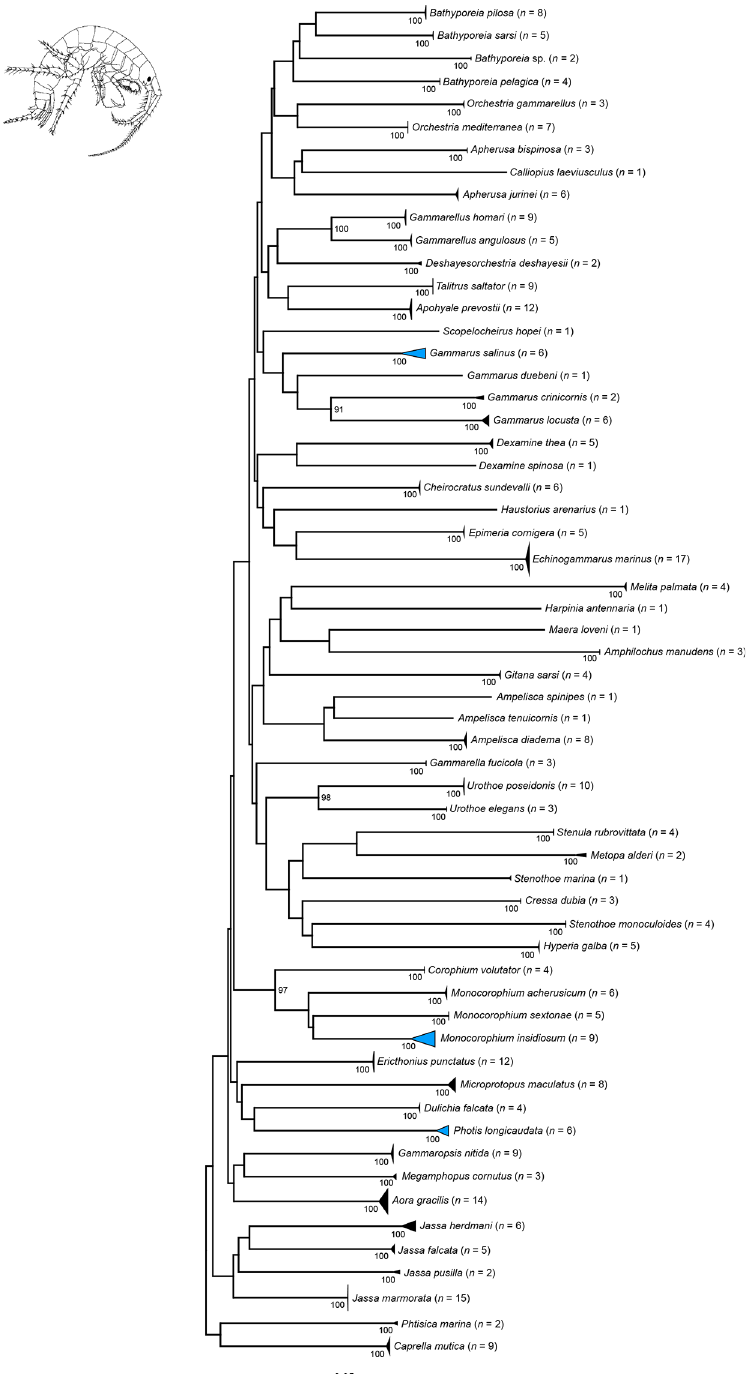
Fig 2. Neighbor joining topology of the analyzed Amphipoda based on Kimura 2-parameter distances. The number of analyzed specimens collapsed into a single node is provided following the species name. Triangles indicate the relative number of individual ’ s sampled (height) and sequence divergence (width). Blue triangles indicate species with intraspecific maximum pairwise distances > 2.2%. Numbers next to nodes represent non-parametric bootstrap values > 90% (1,000 replicates). Drawing of Melita palmata Montagu, 1804 is taken and modified from a previous publication